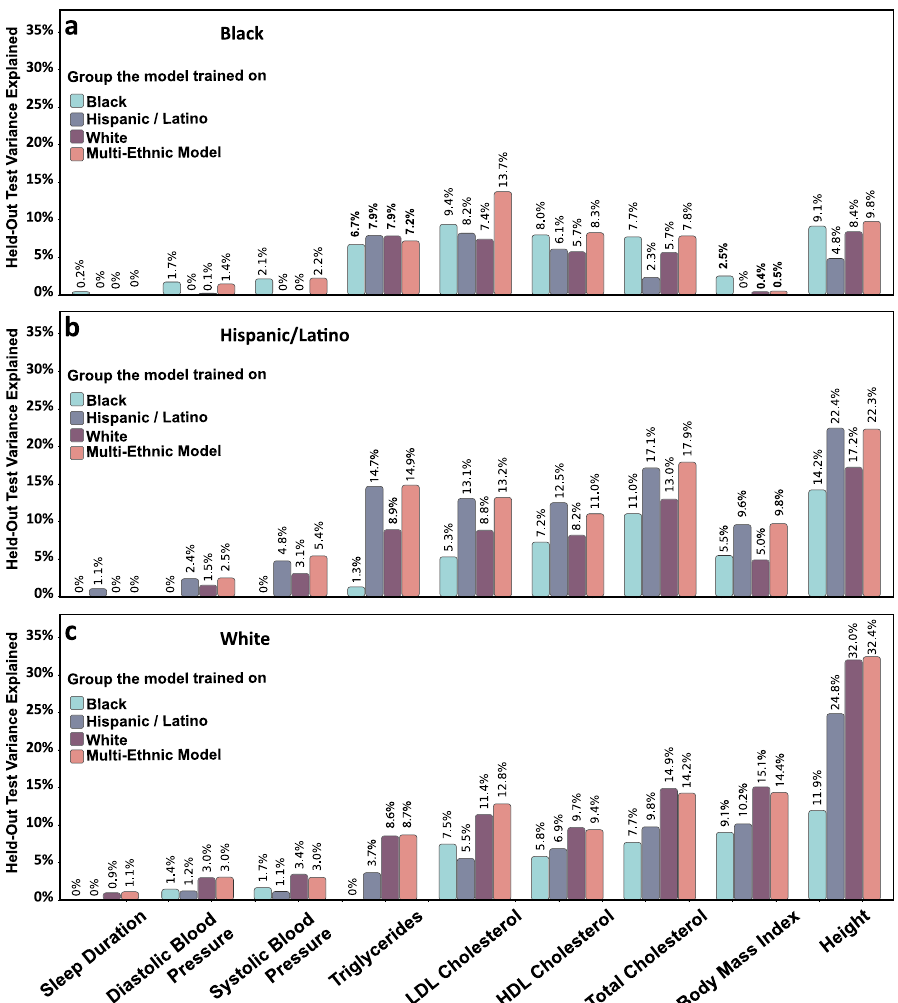
Fig. 5 Multi-ethnic XGBoost model performs on par with the race/ethnic-speci fi c models. XGBoost with PRS models were trained either on the combined dataset containing all participants, (pink) or on each race/ethnic group separately (teal, gray and purple). The models were then evaluated on each of the groups ( a Black, b Hispanic/Latino, and c